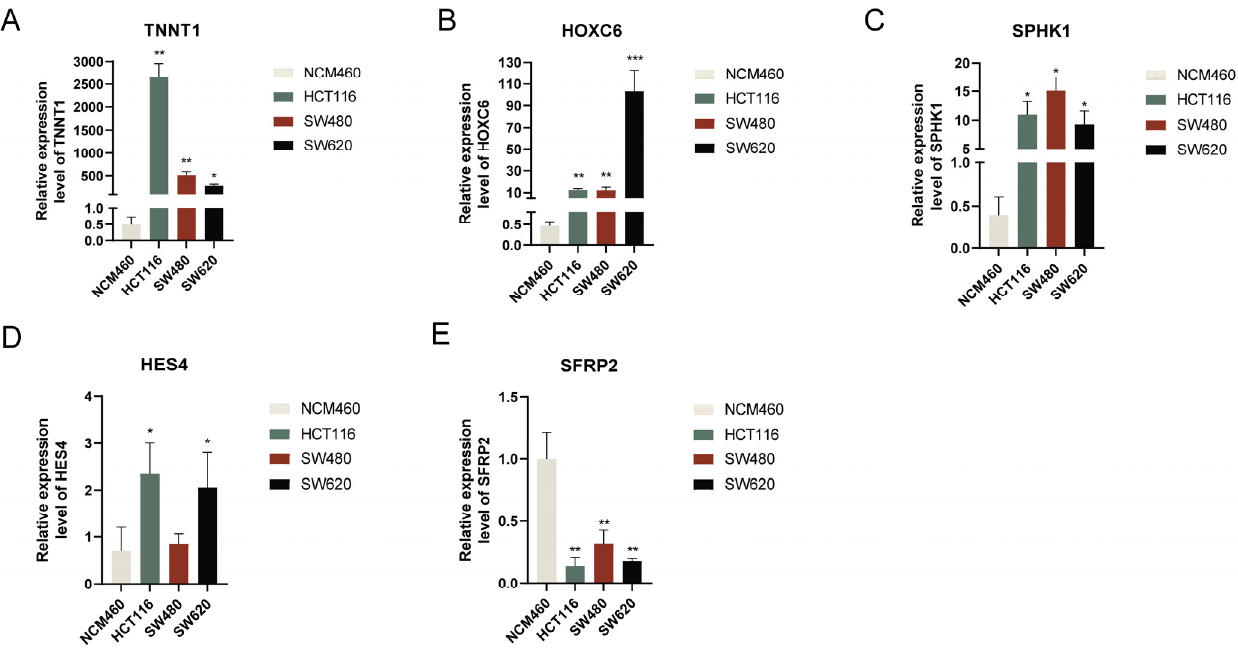
Figure 10. Validation of mRNA expression levels of signature genes in colorectal cancer cell lines. The expression of ( A ) TNNT1, ( B ) HOXC6, ( C ) SPHK1, ( D ) HES4, and ( E ) SFRP2 were detected by RT-qPCR in CRC cell lines. * p < 0.05; ** p < 0.01; *** p < 0.001.